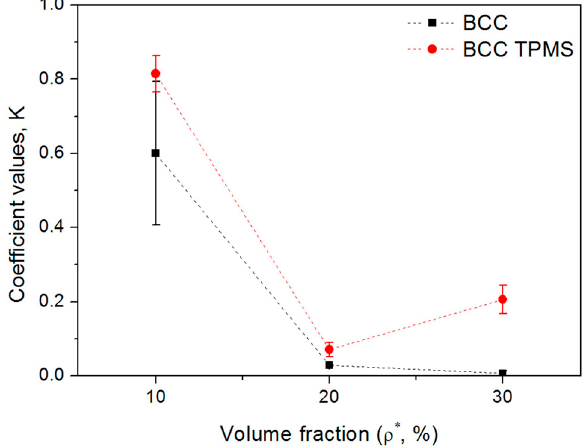
Figure 7. Load-bearing capability (K) of CAD-based and TPMS-based samples after the first plastic failure with different volume fractions (three replicate specimens, means and standard deviations).